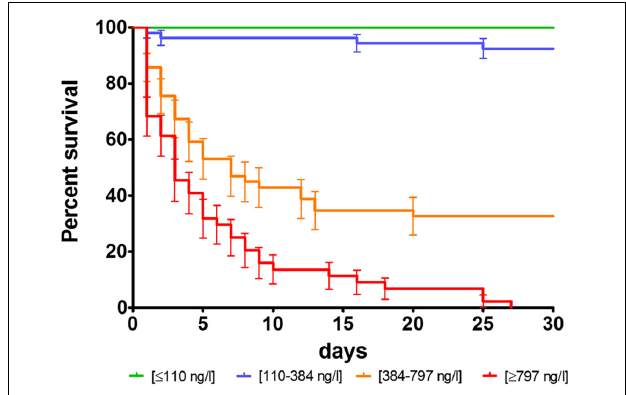
FIGURE 2 | Survival proportions of interleukin 6 according to quartiles of HACORE population. p was < 0.0001 in log-rank test.